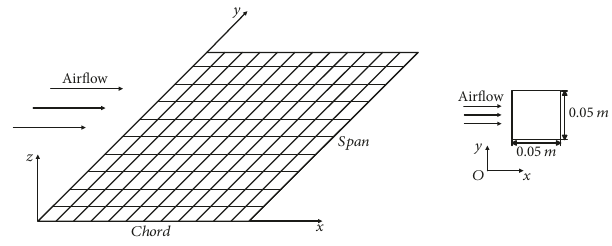
Figure 7: The aerodynamic mesh of the lifting surface with uni fi ed aerodynamic grid cells.